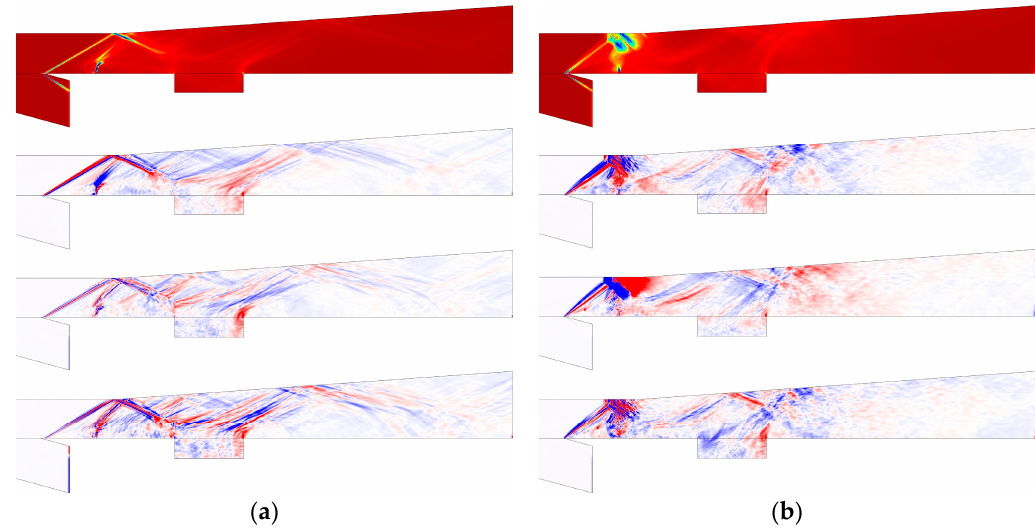
Figure 12. (In order from top to bottom) mean mode, 1st mode, 2nd mode, and 3rd mode of the DMD analysis: pressure gradient at ( a ) 0.75 MPa and ( b ) 1.00 MPa injection pressure.